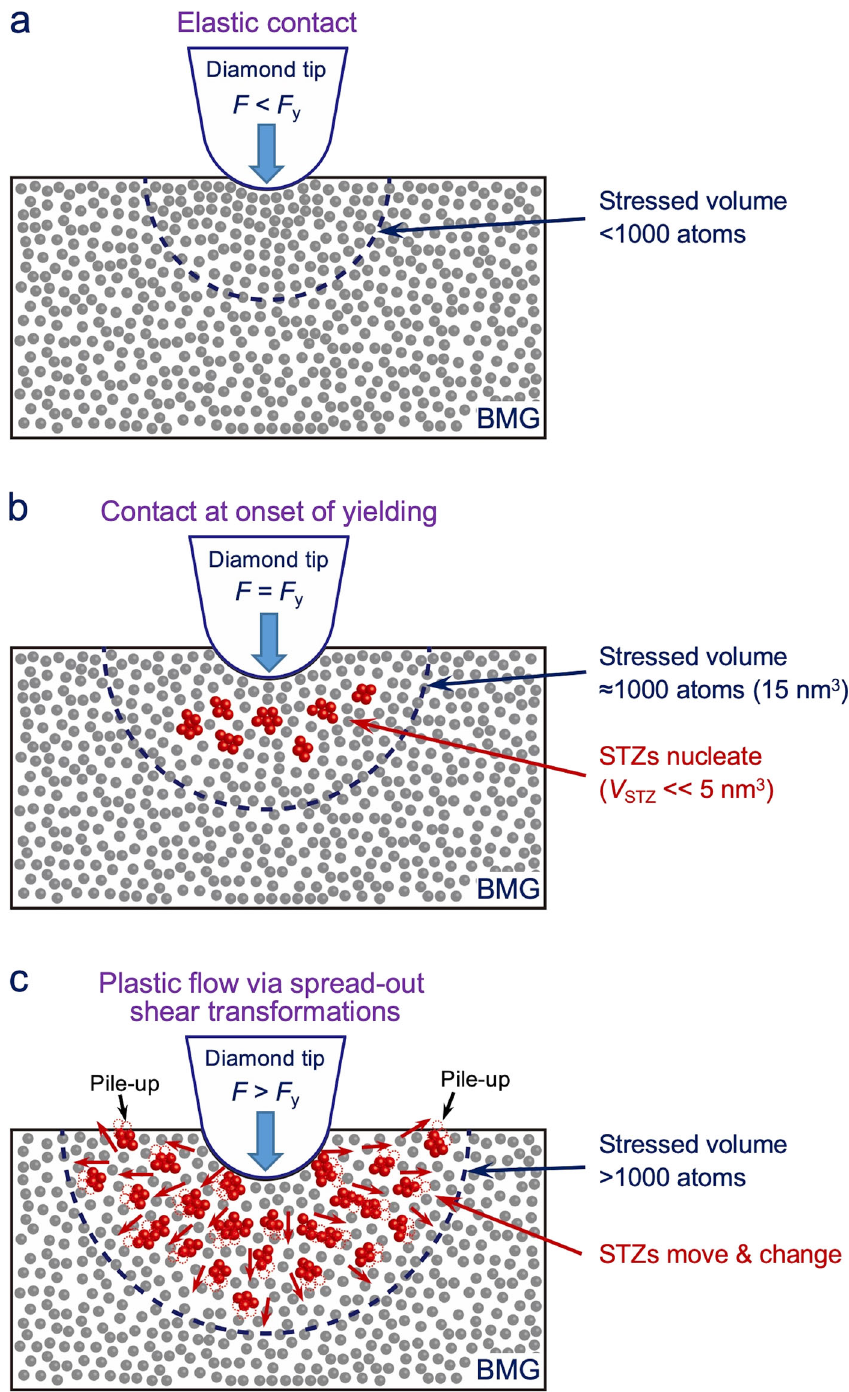
Fig. 6 Sketches illustrating a possible mechanism of atomic-scale plastic fl ow consistent with the experimental fi ndings of this paper. a A diamond tip with very small radius (some nm) is indenting a sample of bulk metallic glass below the material ’ s yield point. In this case, deformation can be well described by the Hertz model, and much <1000 atoms are exposed to signi fi cant stress levels. b Near the onset of yielding, the volume where atoms are subjected to a stress suf fi cient to induce positional changes approaches ≈ 15 nm 2 , comprising ~1000 atoms. At this stage in the process, the atomic-level heterogeneity intrinsic to any glass due to its structural disorder allows small STZs consisting out of only few atoms to nucleate via small displacements in atomic locations. c Once enough STZ have formed, they move without leading to signi fi cant degrees of shear localization. Note, in particular, that these STZs are expected to be transient in its temporal nature, which additionally prevents appreciative degrees of shear